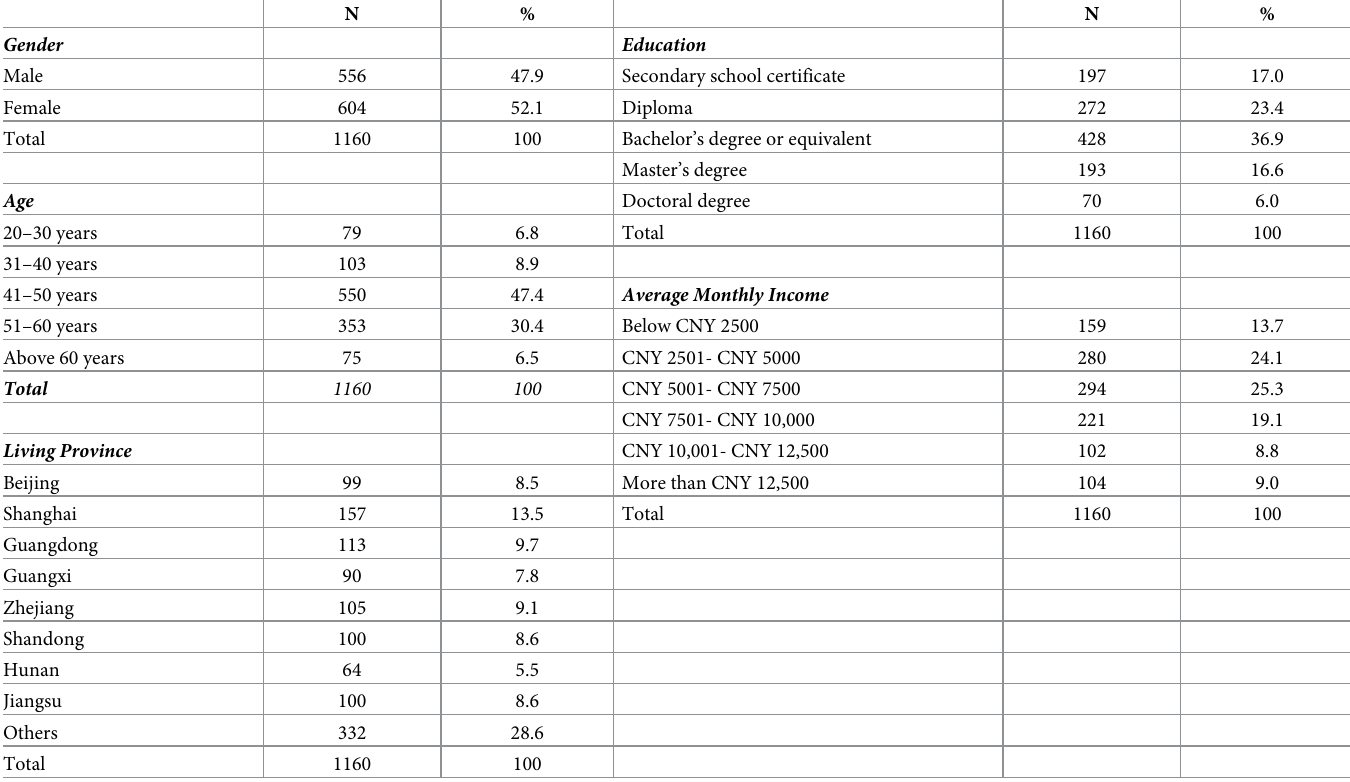
Table 1. Demographic